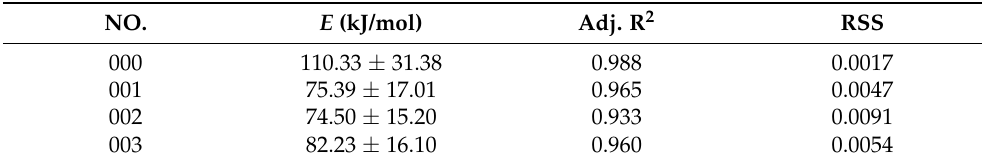
Figure 3. The E vs. α curve of the samples of emulsion matrix using the Flynn–Wall–Ozawa method. Table 4. The average of activation energies and their adjusted r-square and residual sum of squares calculated using the Flynn–Wall–Ozawa method at a value of 0.1–0.9 for the thermal decomposition of the emulsion explosives matrix using the DSC